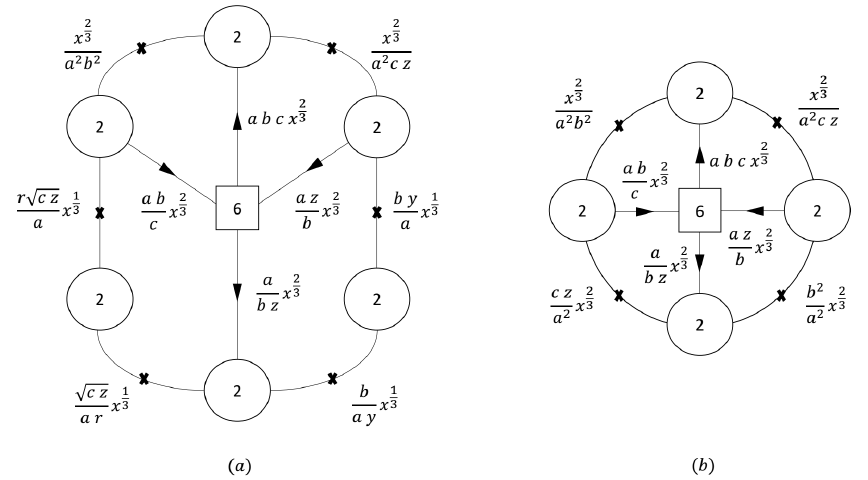
Figure 11 . (a) The 3 d quiver theory we get by gluing three of the tubes in figure 2(b), two with x = 6 and one with x = 0 . There are cubic and quartic superpotentials running along the perimeters of the internal faces. (b) The theory we get from (a) after performing Aharony duality on the bottom left and right SU(2) groups. Again, there are cubic superpotentials running along the perimeters of the internal